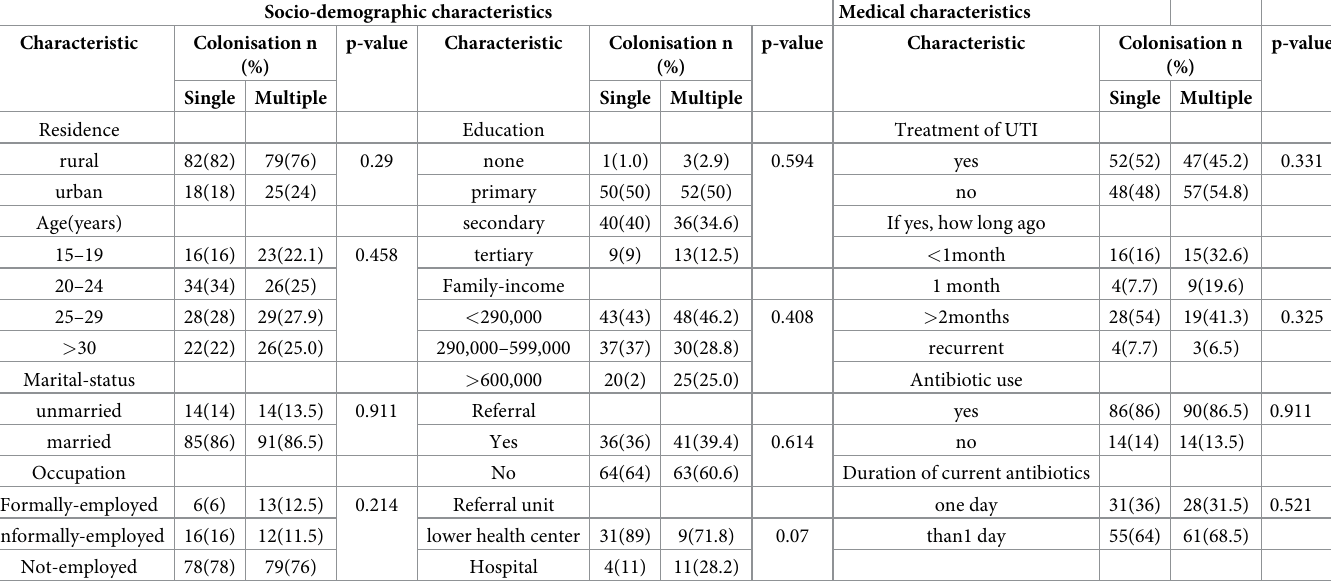
Table 3. Showing association of socio-demographic characteristics and medical characteristics with bacterial species diversity. Socio-demographic